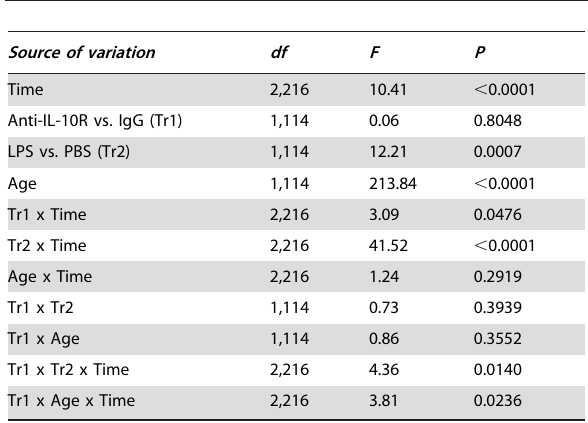
Table 2. Generalized linear mixed model reporting the effect of the experimental treatments and age on the temporal variation in body mass (day 0, 2,